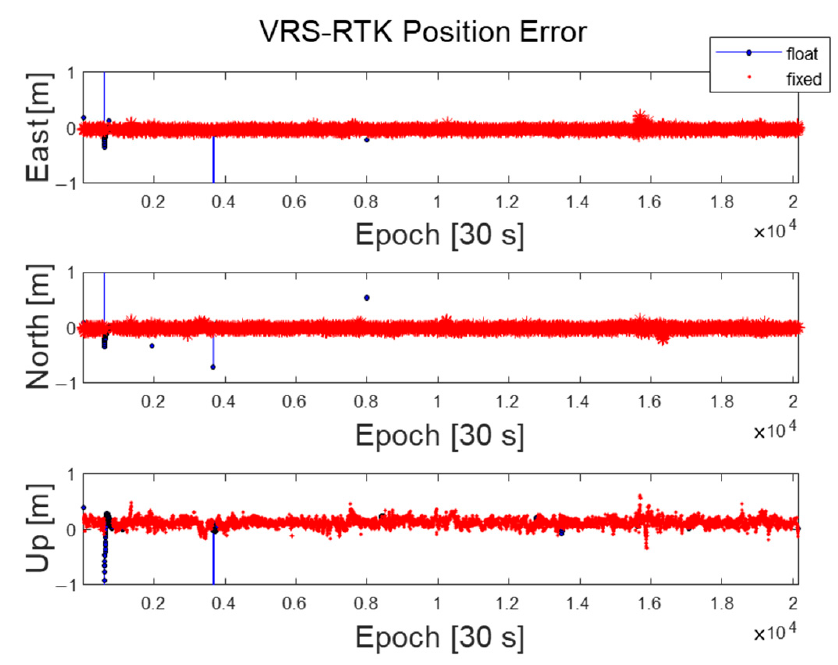
, for GPS and Galileo satellites. sis